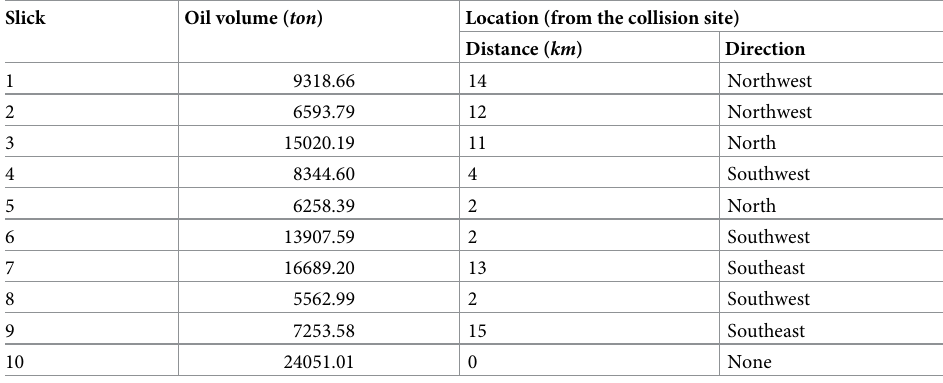
Table 4. Oil volumes and site locations of ten slicks formed after the